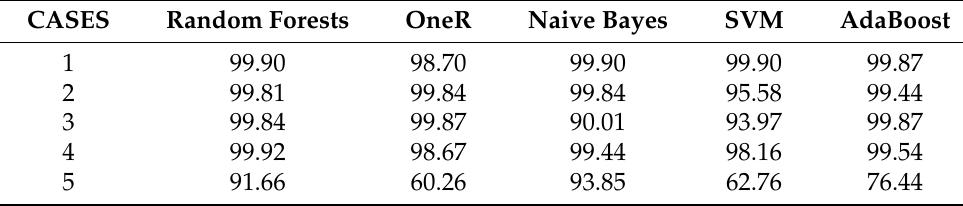
Table 6. Detection rate (%) for different case scenarios.